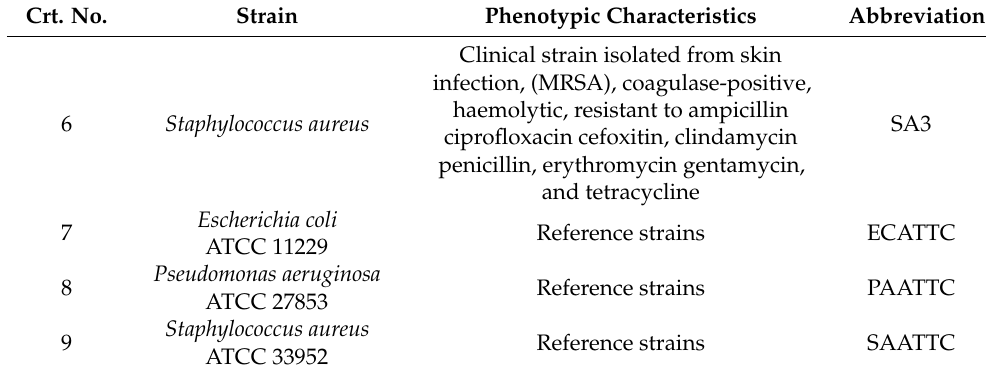
Table 1. Cont. Crt.